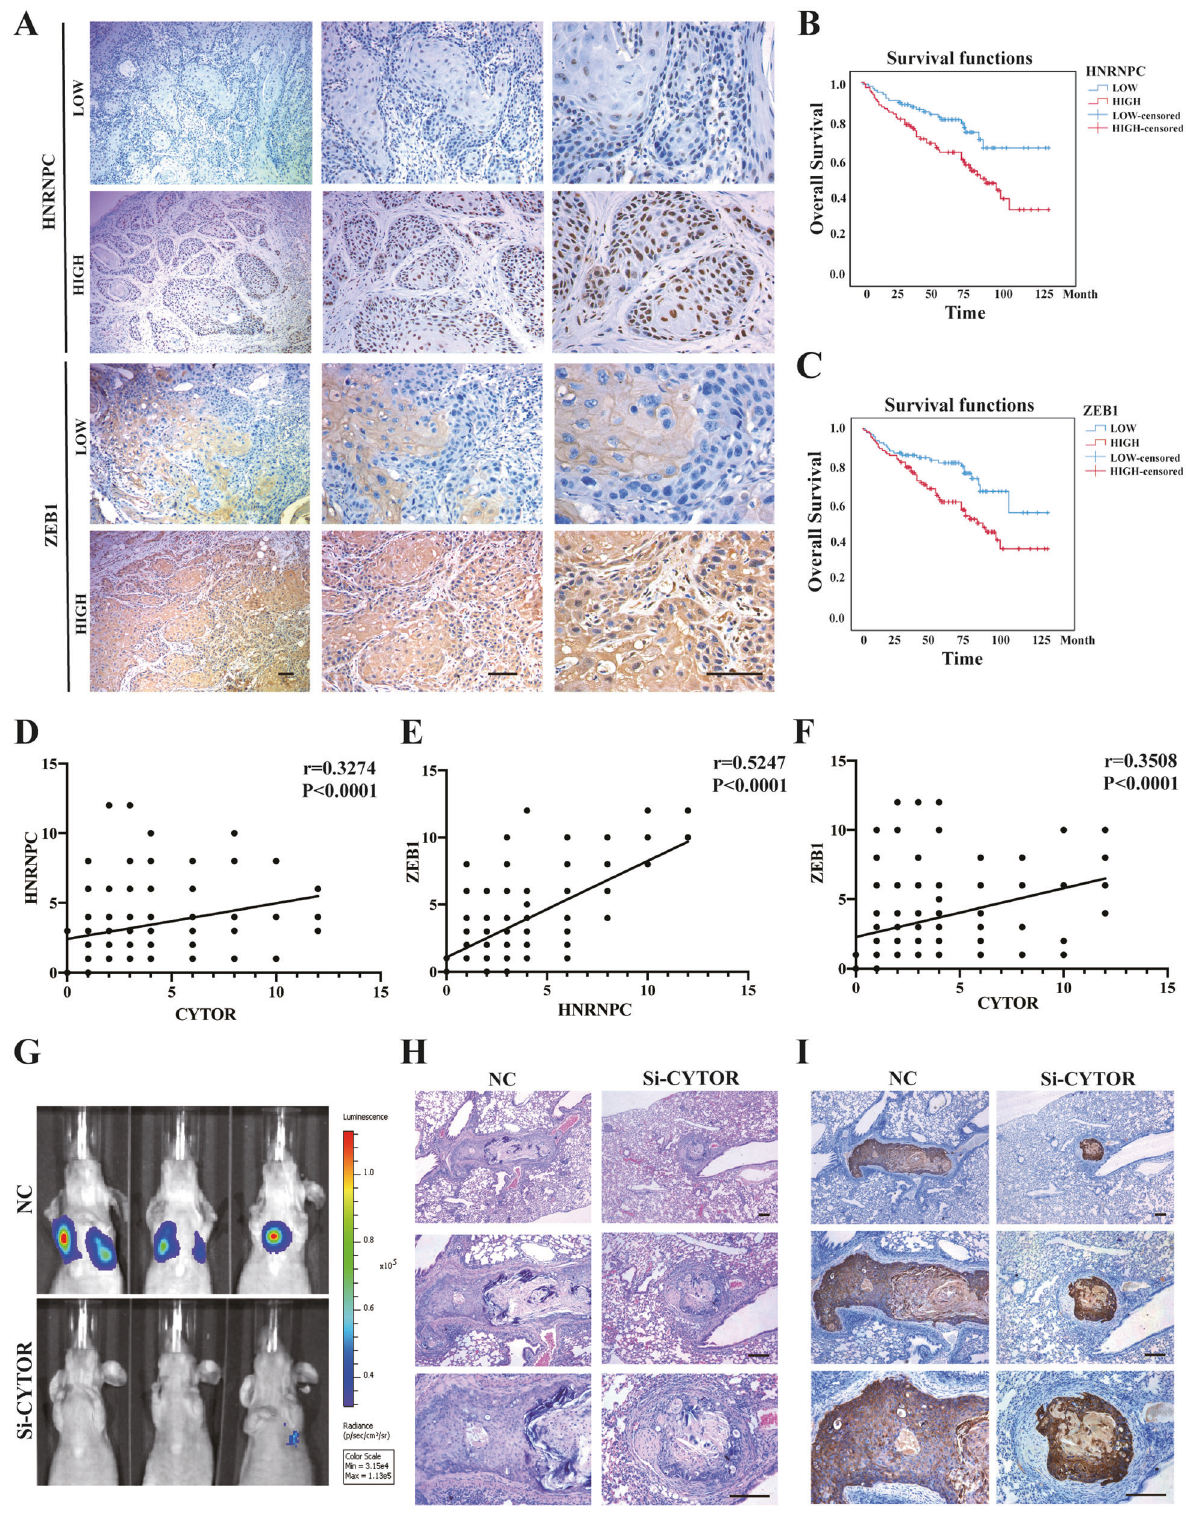
Fig. 7 CYTOR-HNRNPC-ZEB1 axis is a potential therapeutic target for treating OSCC. A HNRNPC and ZEB1 expression in specimens of OSCC patients. ( n = 192) B Kaplan – Meier analysis of OS curves for OSCC patients with HNRNPC-low and HNRNPC-high expression. C OS curves for OSCC patients with ZEB1-low and ZEB1-high expression. D Correlations between CYTOR and HNRNPC, E HNRNPC and ZEB1, and F CYTOR and ZEB1 were determined by Spearman ’ s correlation assay. G Nude mice were injected with the luciferase-labeled oral cancer cells, si-CYTOR encapsuled NMOFs (UiO-66-NH 2 ) were injected at day 21 post-injection of cancer cells. Lung-metastasized cells were measured at day 45 post-injection. H Representative images of H&E staining of lung-metastasized cancer cells. I Representative images of IHC staining of cytokine in